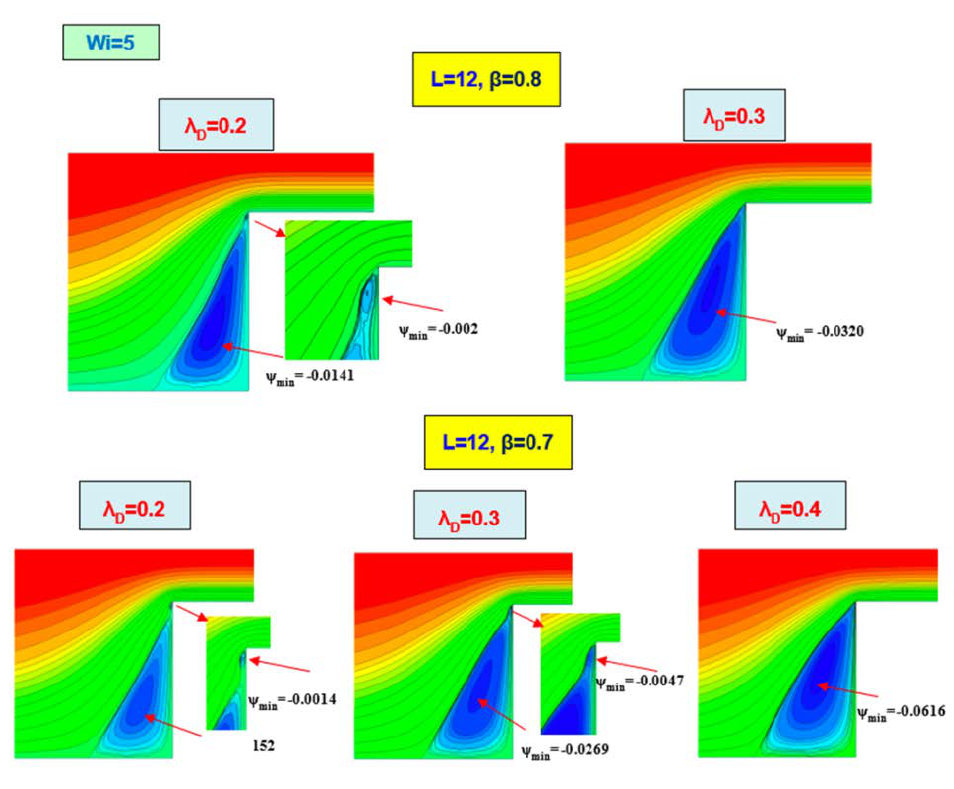
Figure 15. Vortex-intensity ( − Ψ min ); α aspect = 4; swIM [ L = 12, β = {0.7, 0.8}, λ D = {0.2, 0.3,